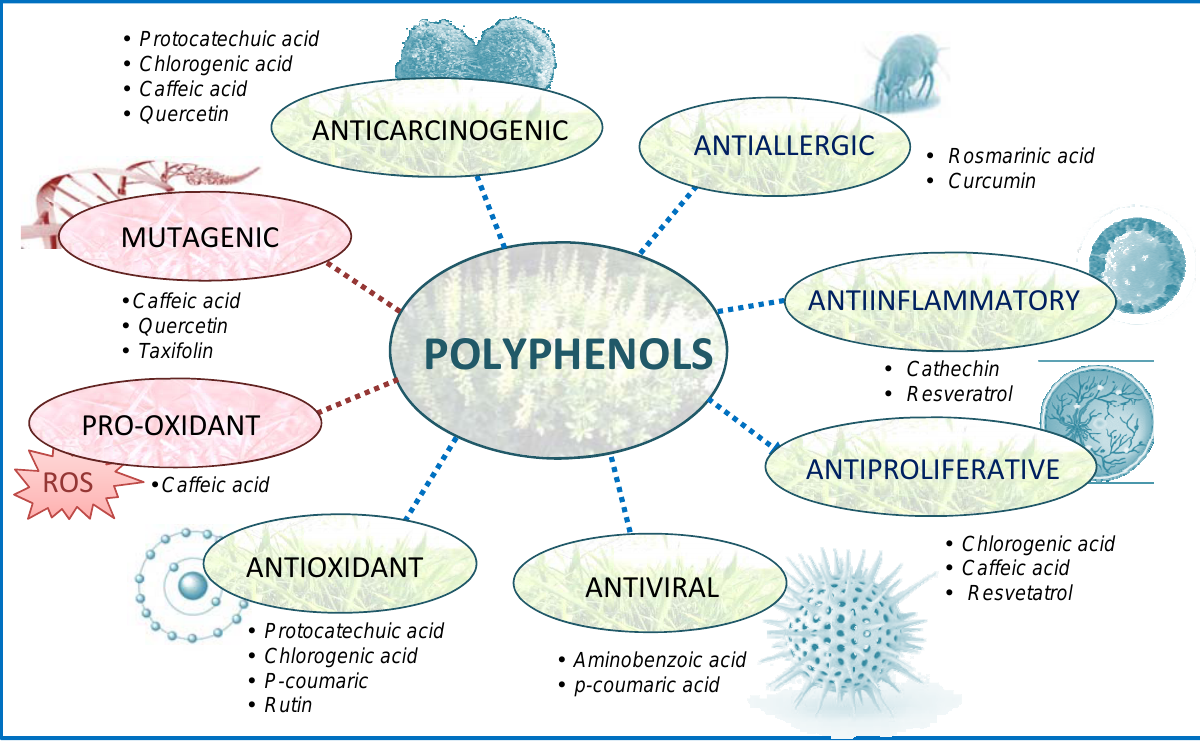
Figure 1. Polyphenols and their biological properties . Polyphenols have a great variety of beneficial effects like anticarcinogenic (e.g., quercetin, protocatechuic acid) antiallergic (e.g., rosmarinic acid, curcumin), antiinflammatory (e.g., cathechin, resveratrol), antiproliferative (e.g., chlorgenic acid, caffeic acid, resveratrol), antiviral (e.g., aminobenzoic acid, p-coumaric) and antioxidant (e.g., rutin, chlorgenic acid, quercetin on human health. Their antioxidant properties and abilities to modulate several enzymes are also important. Some flavonoids have also mutagenic (e.g., quercetin) and/or prooxidant effects (e.g., caffeic acid) and they may interfere with essential biochemical